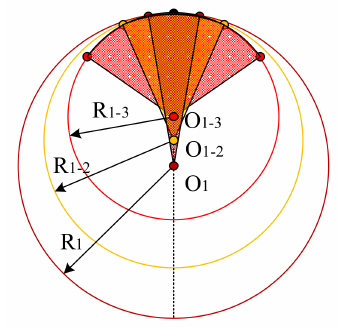
Figure 4. Centers of different coverages of the sphere.